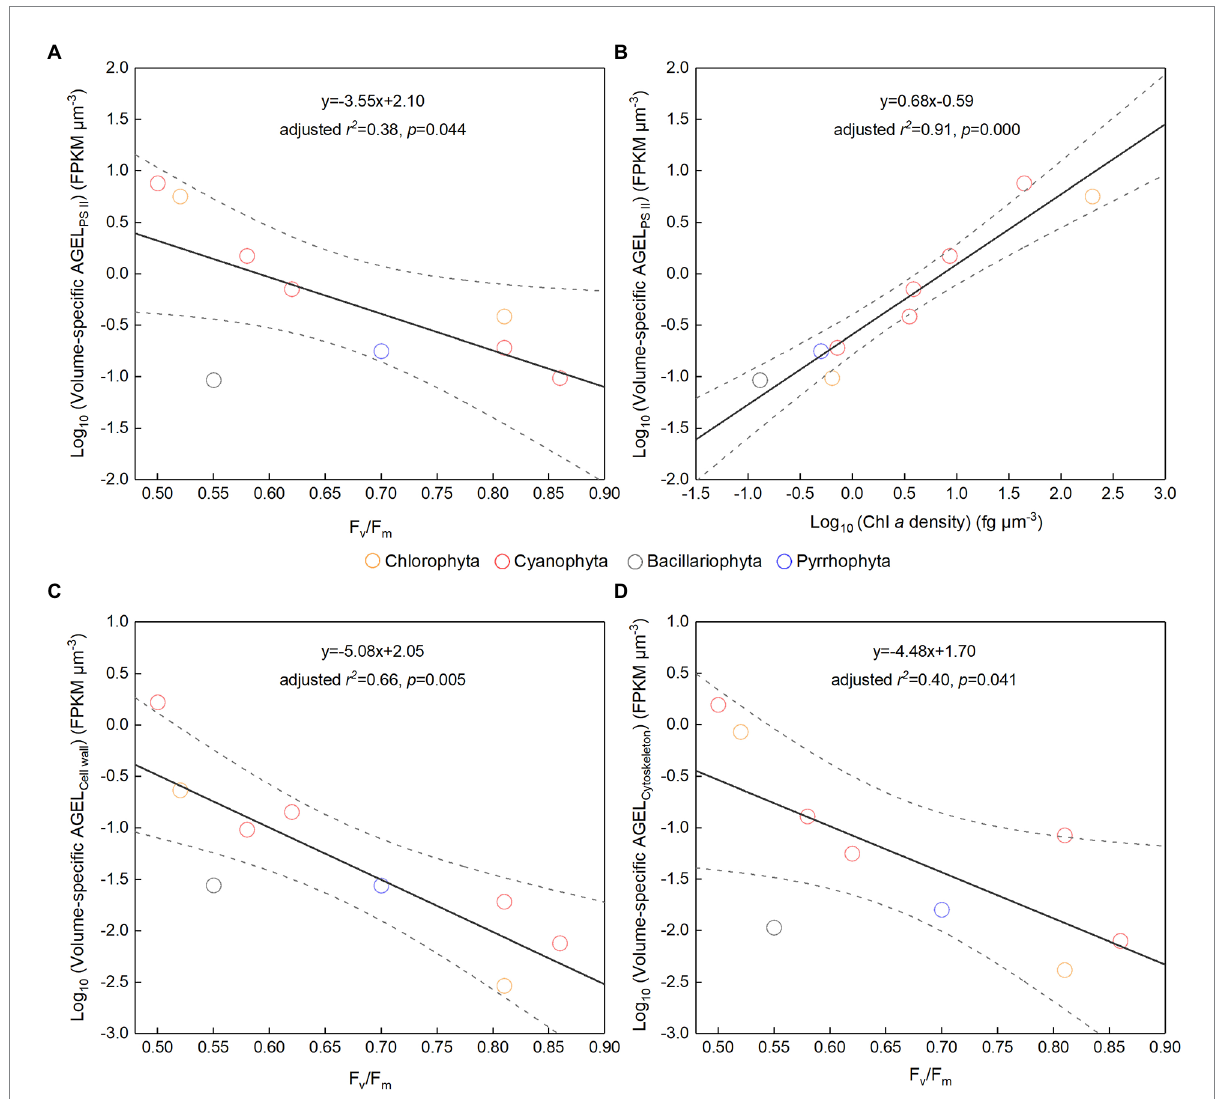
FIGURE 5 (A) F v / F m versus volume-specific average gene expression level (AGEL) of Photosystem II (PS II) proteins; (B) Chlorophyll a (Chl a ) density versus volume-specific AGEL of PS II proteins; (C) F v / F m versus volume-specific AGEL of proteins involved in cell wall; (D) F v / F m versus volume-specific AGEL of proteins involved in cytoskeleton; all for the phytoplankton assemblage in Tianjin’s reservoirs. Different color point represents different dominant algal group in each sampling site. The dotted lines represent the 95% confidence